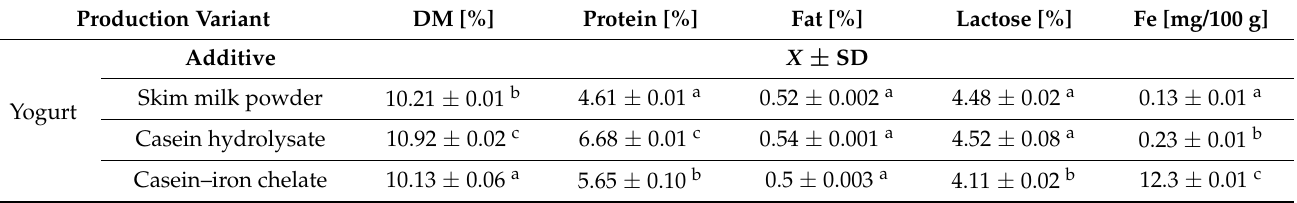
Table 2. Composition parameters characteristic of yoghurts produced in various production